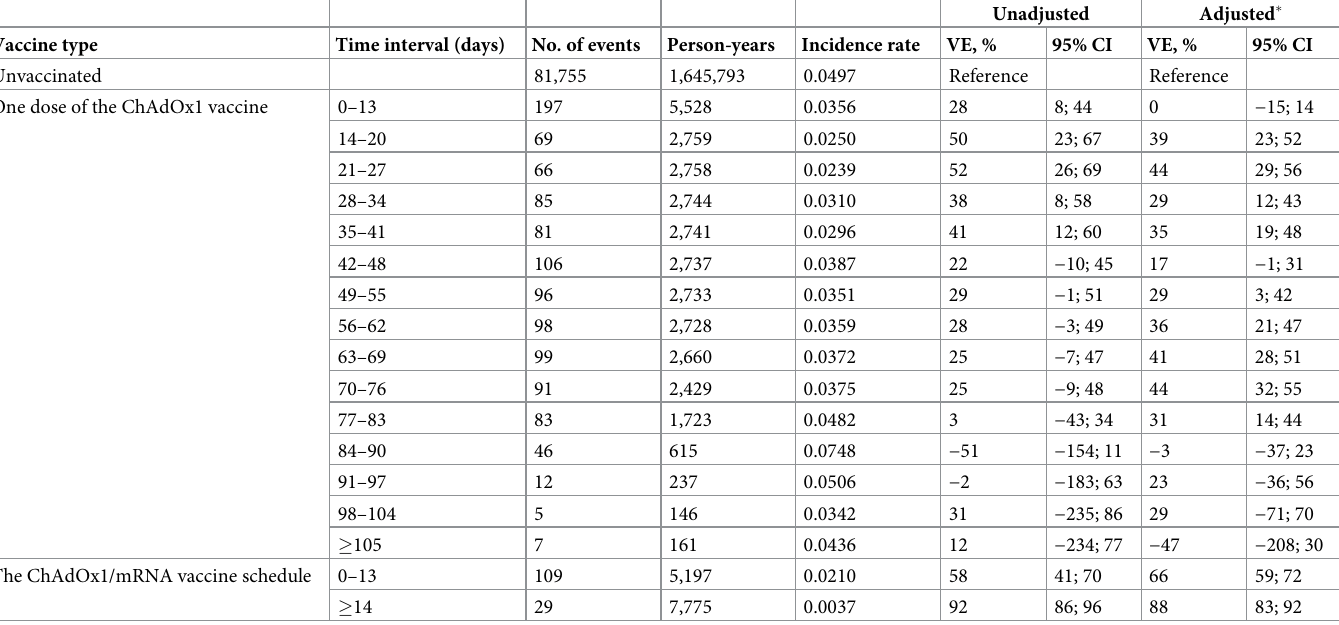
Table 2. Unadjusted and adjusted VE estimates against RT-PCR SARS-CoV-2 infection of 1 dose of the ChAdOx1 vaccine and the ChAdOx1/mRNA vaccine schedule. Time interval (days)